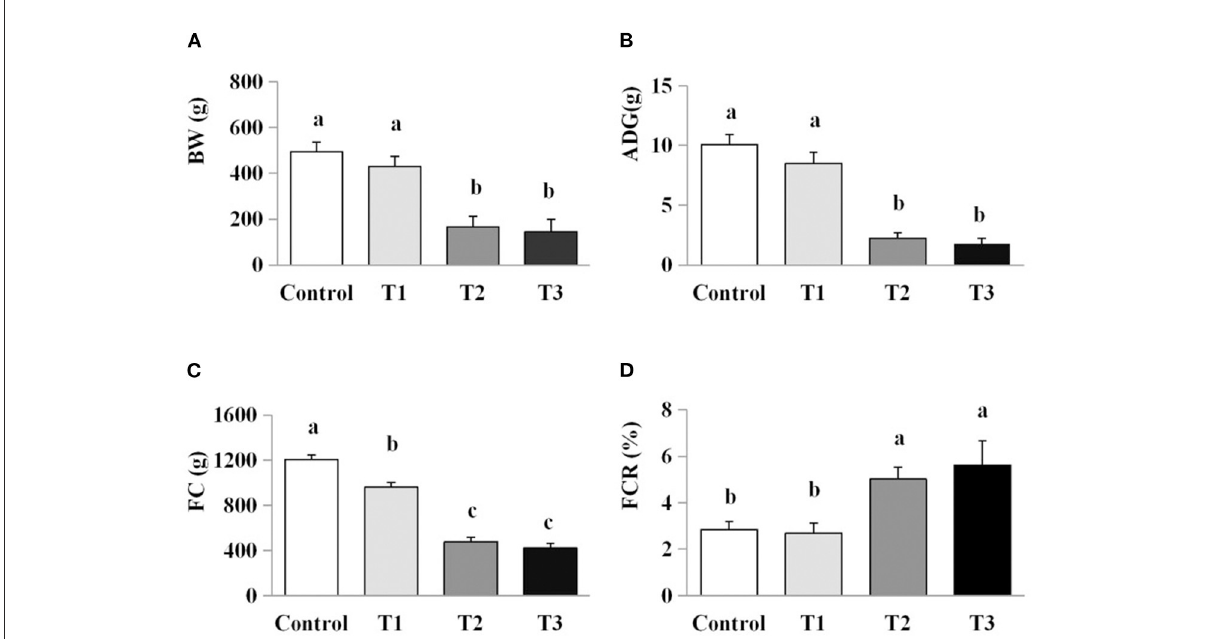
FIGURE1 Effects of AFB 1 on the growth performance of chicks. (A) BW, body weight. (B) ADG, average daily gain. (C) FC, feed consumption. (D) FCR, feed conversion ratio. Control: control group. T1: low doses of AFB 1 group. T2: medium doses of AFB 1 group. T3: high doses of AFB 1 group. Data represent the means ± SD values of six replicate cages and were compared using one-way analysis of variance (ANOVA) followed by Duncan’s multiple comparison tests. Different letters on the same row indicate significant differences ( P < 0.05).